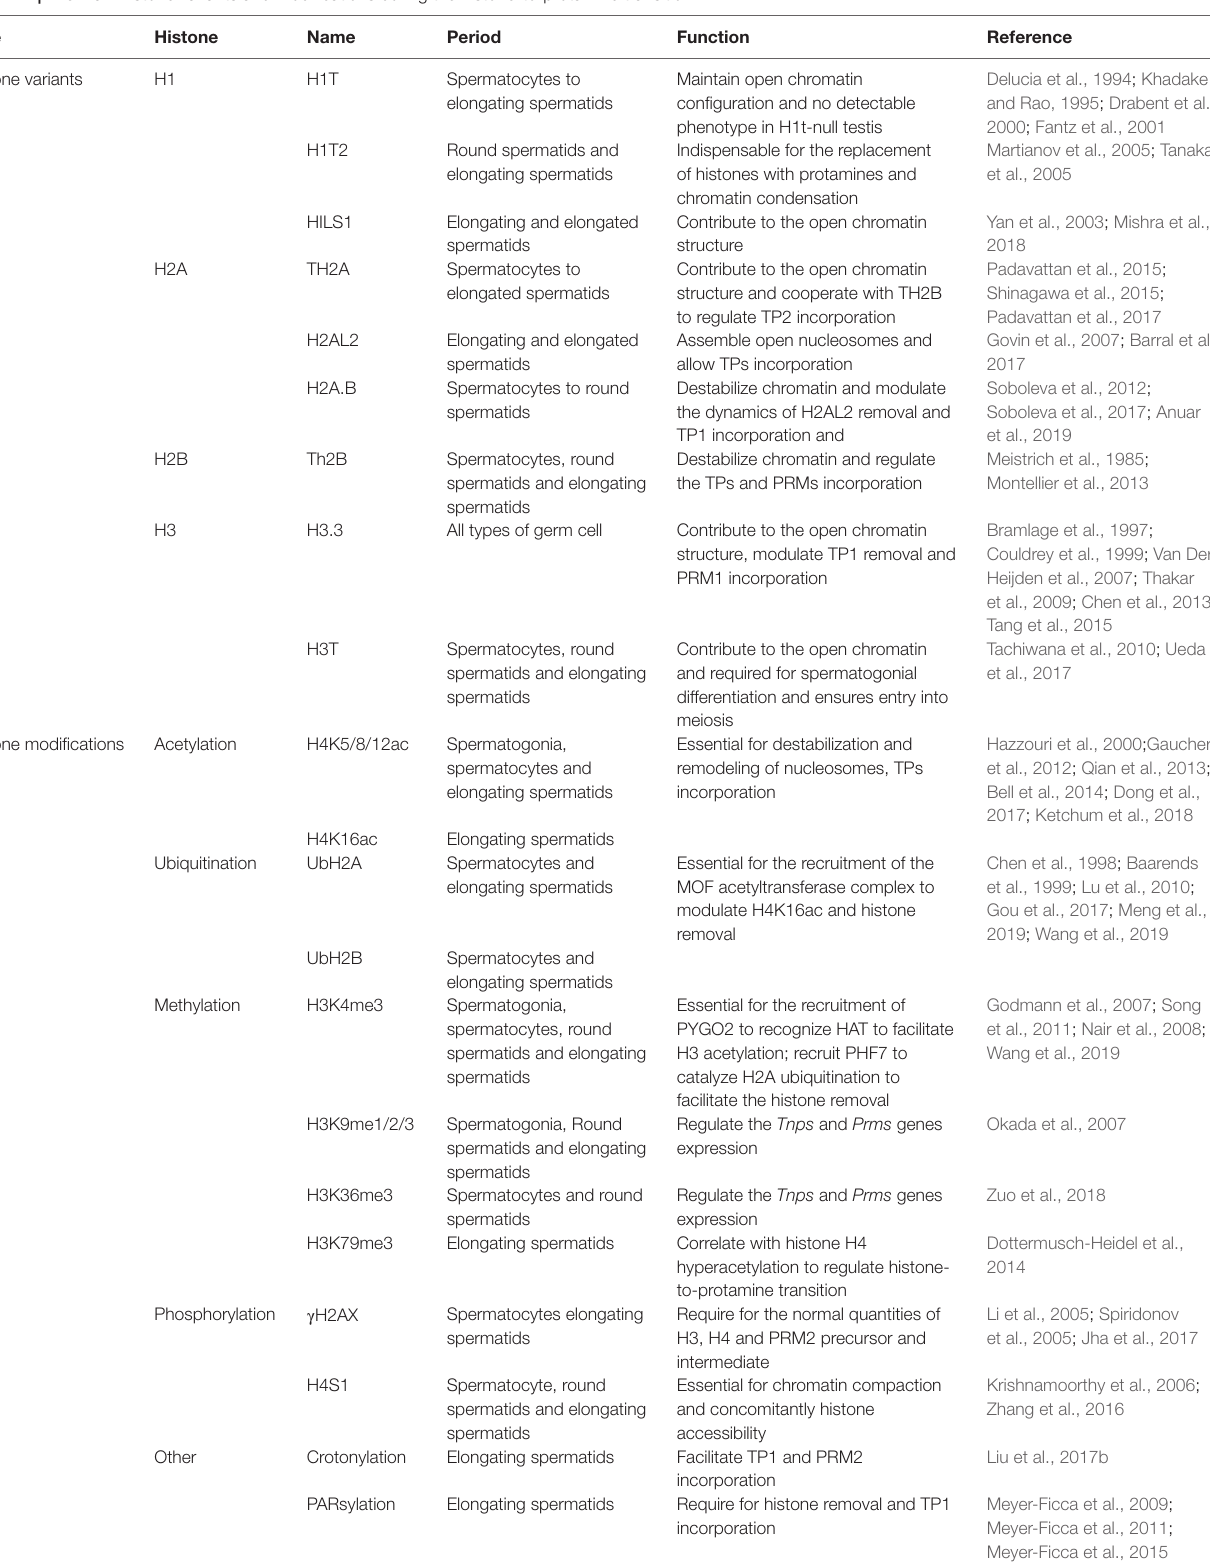
TABLE 1 | The main histone variants and modifications during the histone-to-protamine